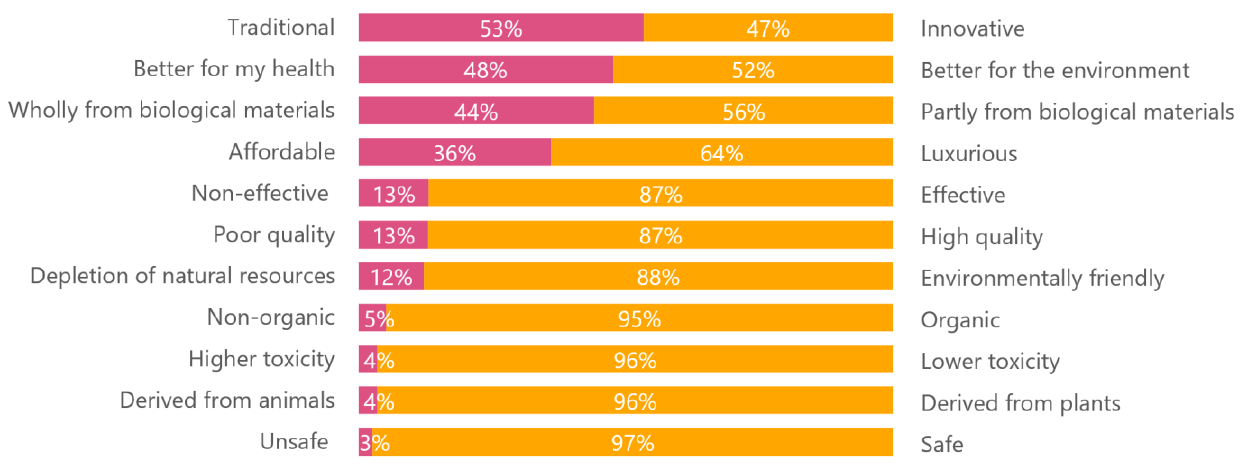
Figure 9. Proportion of selected adjectives for “bio-based”.